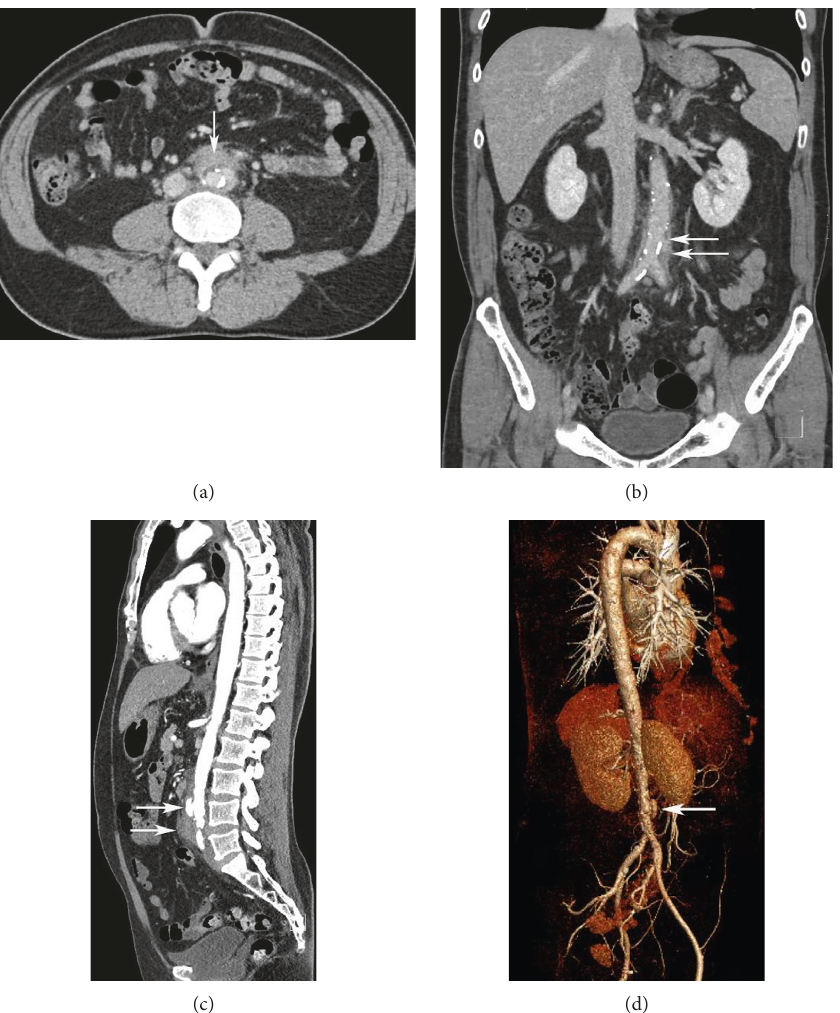
Figure 1: (a) Transverse view of abdominal CT shows periaortic soft tissue thickening adjacent to aorta (arrow). (b) Coronal view of abdominal CTwithout IV contrast shows disruption of calcification in aortic wall (upper arrow) and periaortic soft tissue thickening around the infrarenal aorta and around bifurcation of aorta into common iliac arteries (lower arrow). (c) Sagittal view of abdominal CT, with IV contrast, shows pseudoaneurysm formation (upper arrow) and periaortic soft tissue thickening around the infrarenal aorta (lower arrow). (d) Reconstructive CT angiogram shows pseudoaneurysm formation